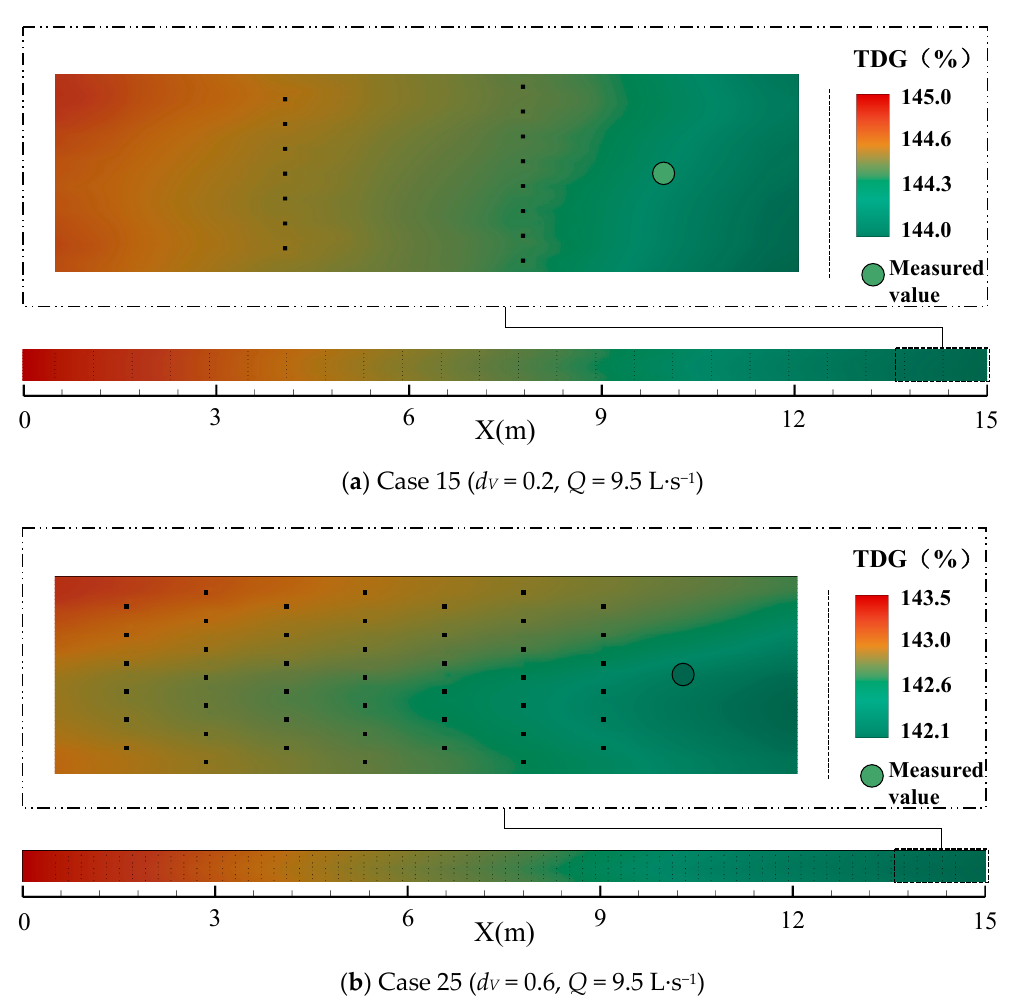
Figure 10. Comparison between simulation results and experimental data of TDG saturation.